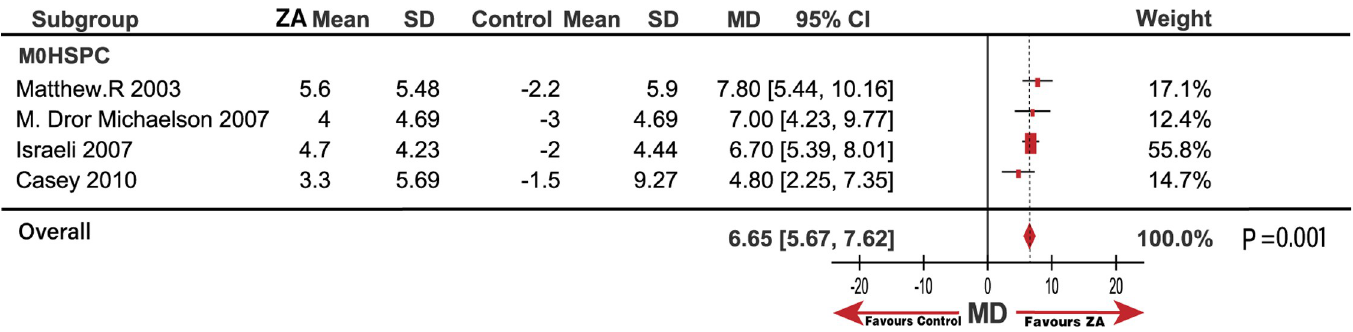
Fig 11. Forest plot with odds ratio (MD) of bone mineral density (BMD) in subgroup of HSPC.